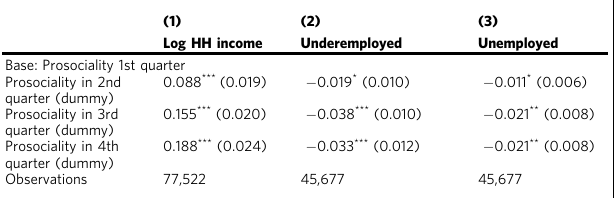
Table 2 Analyses of nonlinear relations between labor market success and